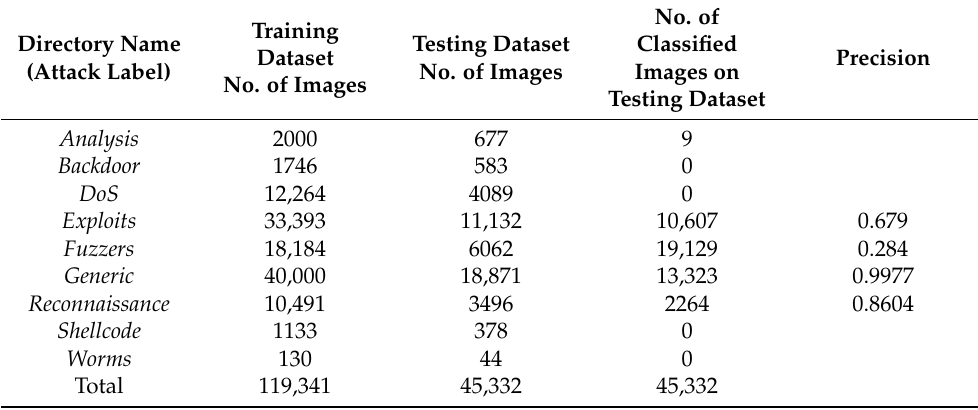
Table 7. Precision of recognized images using ML.NET created model on UNSW-NB15 training dataset for attacks